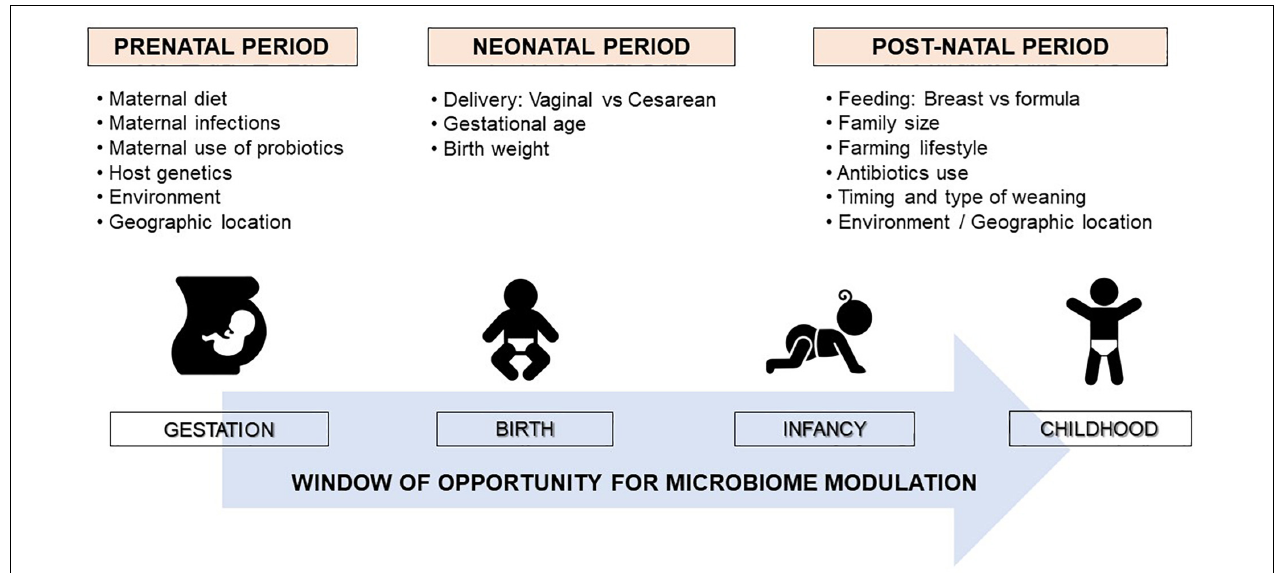
FIGURE 1 | Factors shaping the human microbiome development. The neonatal microbiome is a delicate and highly dynamic ecosystem that undergoes rapid changes in composition in the first few years of life determined by several pre and perinatal factors. The maturation of the gut microbiota toward an adult-like structure largely occurs by the age of 2 or 3 years. Therefore, early infancy could be a critical period for modulating the microbiota to promote healthy growth and